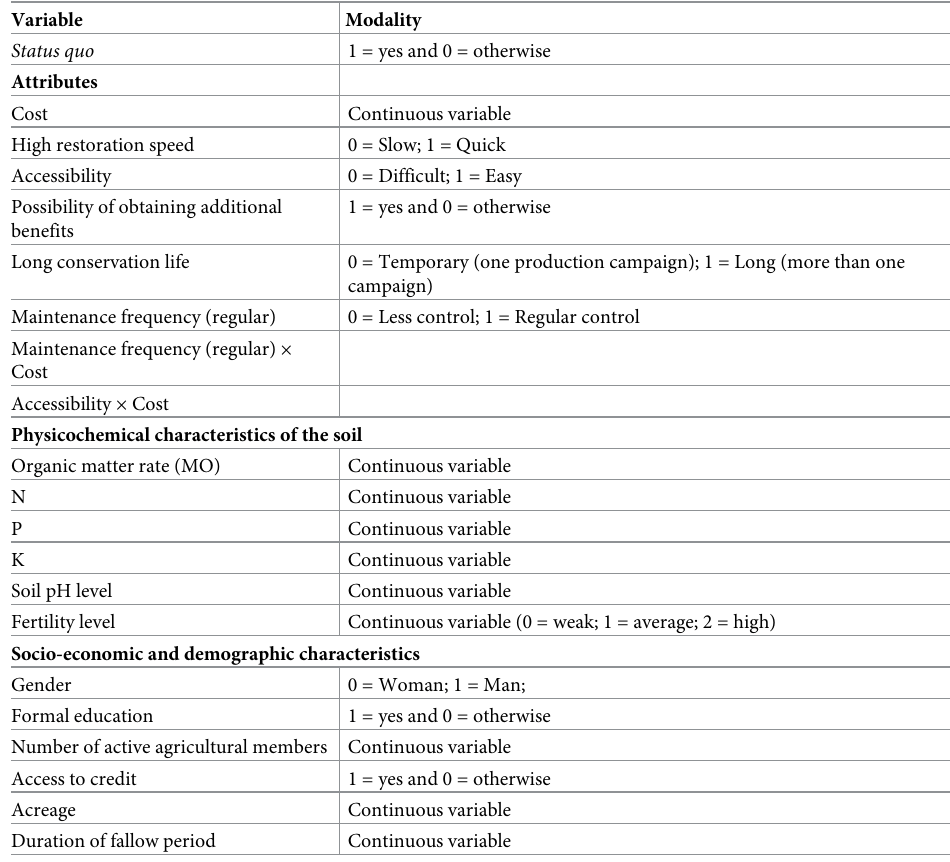
Table 3. Variables used in econometric models.